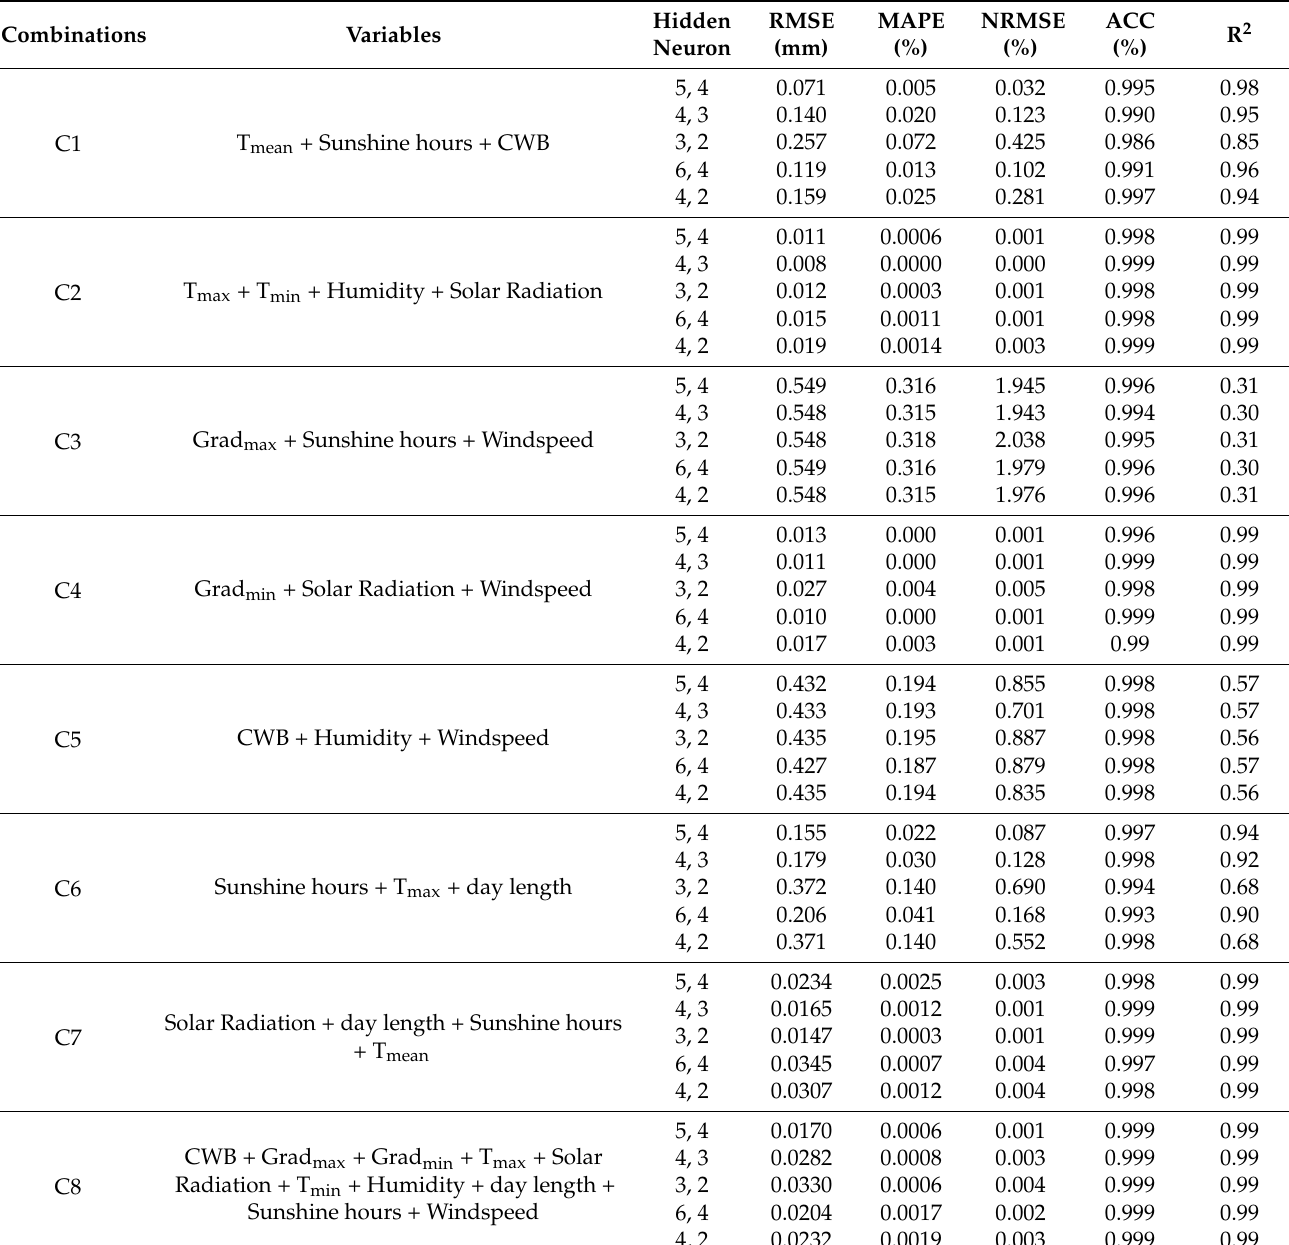
Table 1. Top five architectures of hidden configurations from different variable combinations: